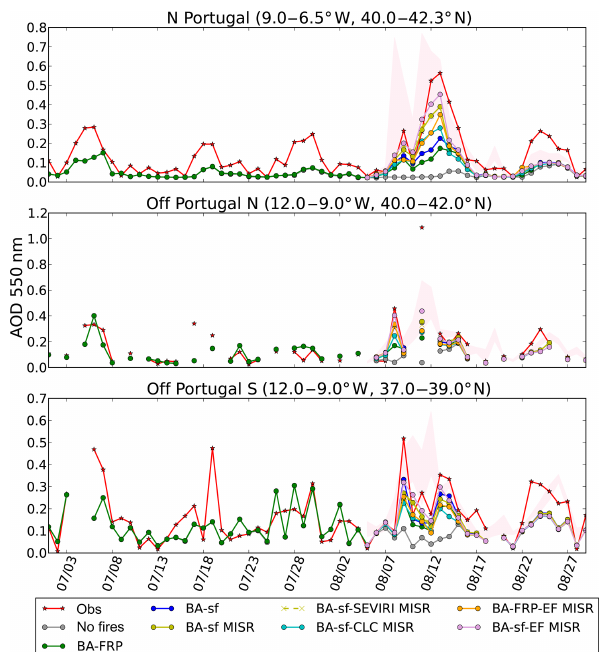
Figure 15. Daily average observed (MODIS) and simulated (CHIMERE) AOD at 550nm during July–August 2016 over three subregions (mapped in Fig. 9). Results from different CHIMERE simulations are plotted (described in Table 4). The spread between the simulated regional average and maximum without collocation with MODIS data is also shown (shaded red